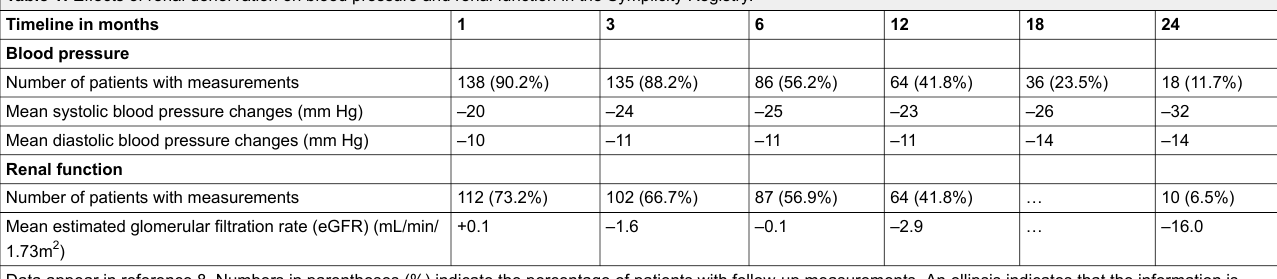
Data appear in reference 8. Numbers in parentheses (%) indicate the percentage of patients with follow-up measurements. An ellipsis indicates that the information is